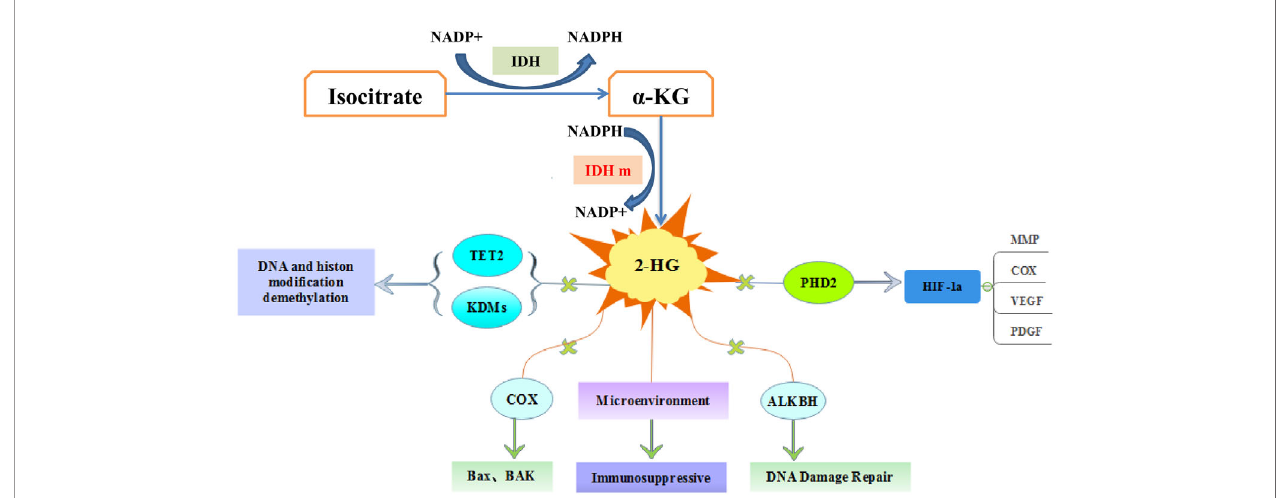
FIGURE 2 | The molecular pathways of IDH mutations in tumorigenesis. 2-hydroxyglutarate competitively inhibits multiple a -ketoglutarate dependent dioxygenases, thereby causing widespread epigenetic changes that result in a global dysregulation of gene expression. 2-HG inhibits prolyl hydroxylases (PHD) and increases HIF-1 a stabilization and result in impairment of collagen maturation. 2-HG can promote apoptosis by inhibiting cytochrome c oxidase (COX), and associate with tumor